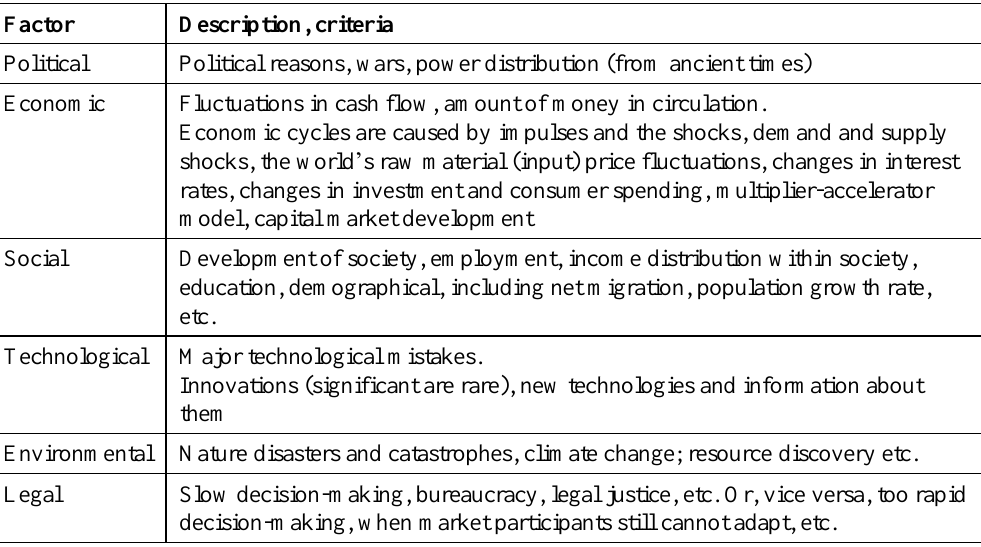
Table 7. Causes and Affecting Factors of the